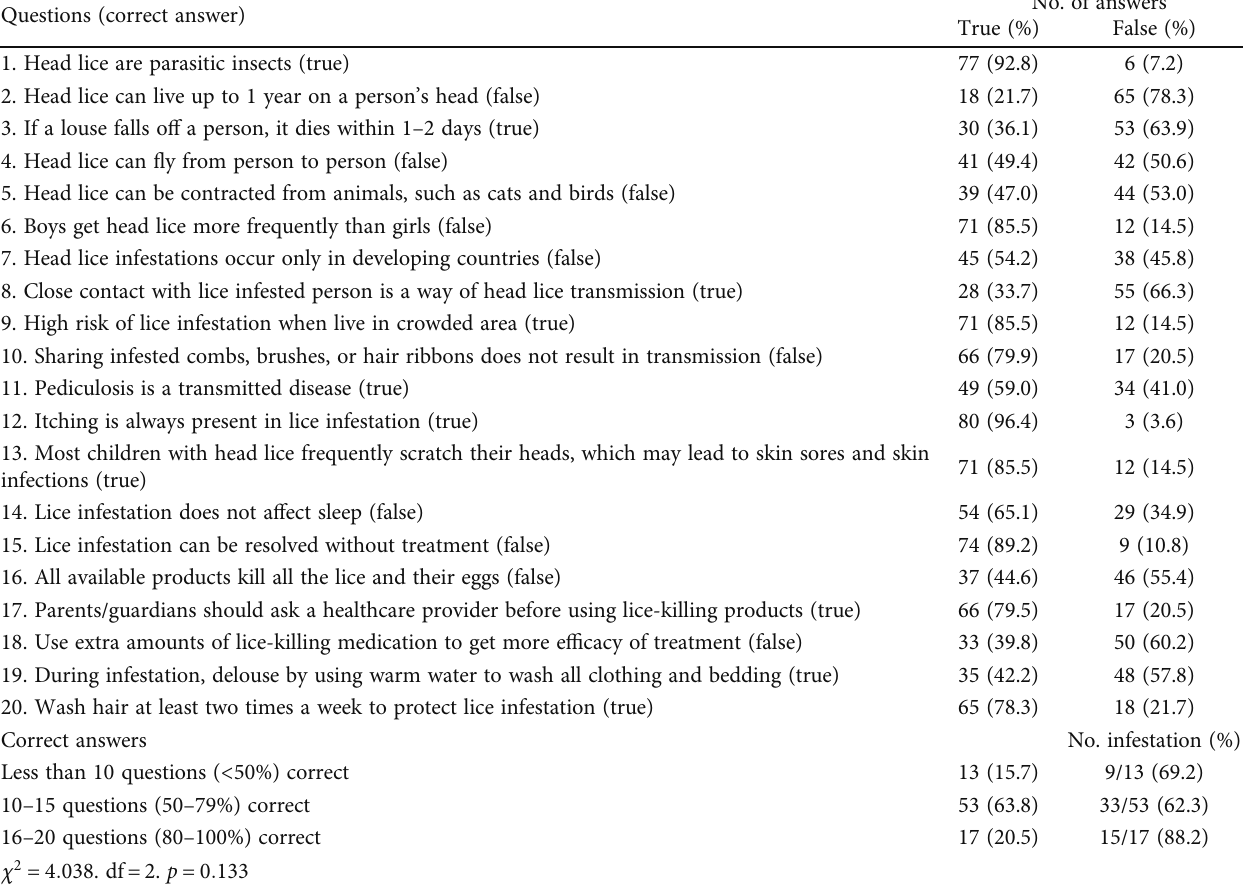
Table 3: Knowledge of head lice exhibited by parents/guardians in schoolchildren in Lak Hok subdistrict. Questions (correct